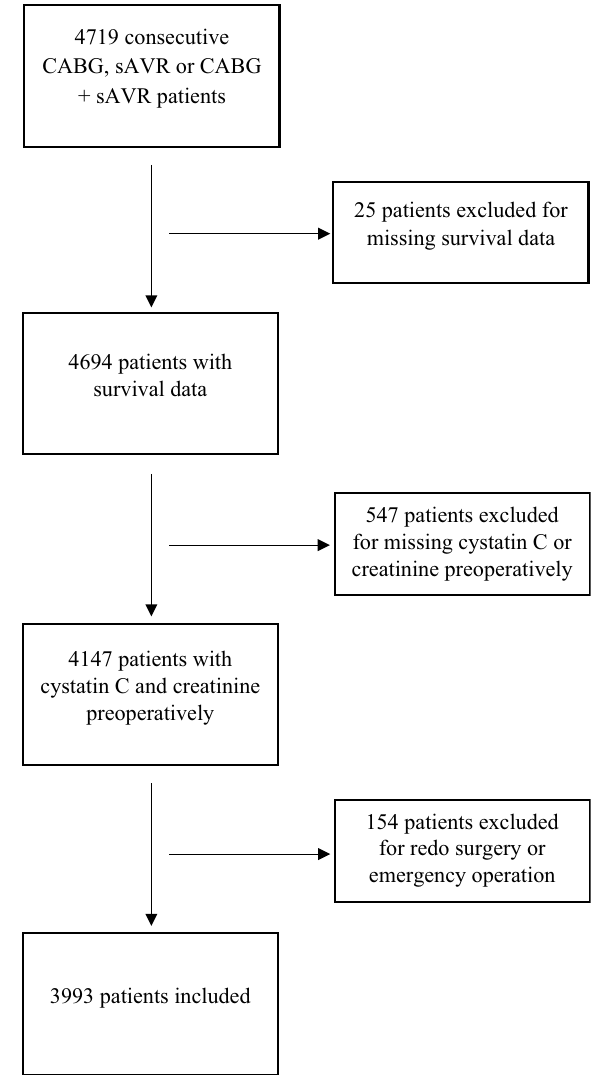
Figure 1. Flow diagram of the study population. CABG coronary artery bypass graft, sAVR surgical aortic valve